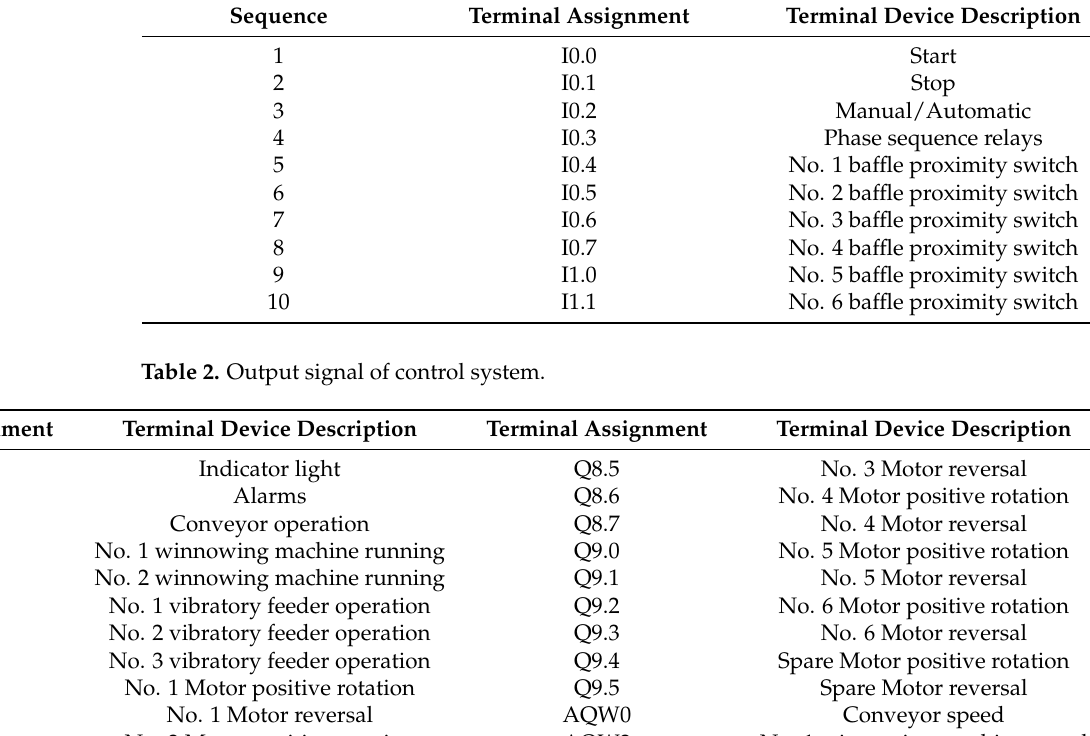
Table 1. Input signal of control system.